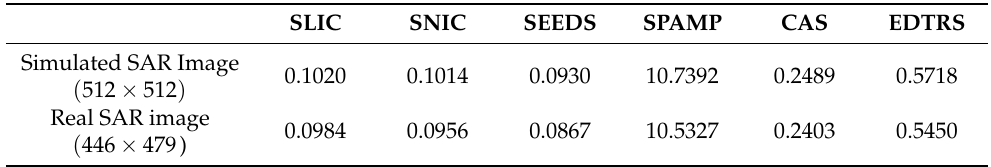
Table 4. Computation times of four methods in